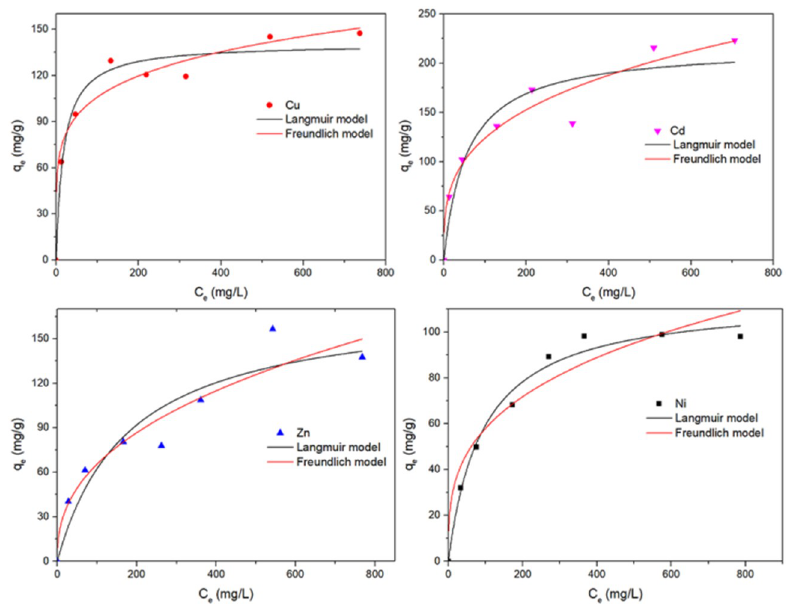
Figure 4. The adsorption isotherm by CA beads in the Cu(II), Zn(II), Ni(II) and Cd(II) heavy metal solution at different initial concentrations. Reaction conditions: T = 293 K, [Cu(II)] 0 = [Zn(II)] 0 = [Ni(II)] 0 = [Cd(II)] 0 = 0–800 mg/L, reaction time = 12 h. Table 2. Parameters o f the Langmuir and Freundlich models. q m = the maximum adsorption capacity for heavy metal ions; K L and K F = equilibrium constants of Langmuir and Freundlich, respectively; n = Freundlich exponent; R 2 = coefficient of determination.